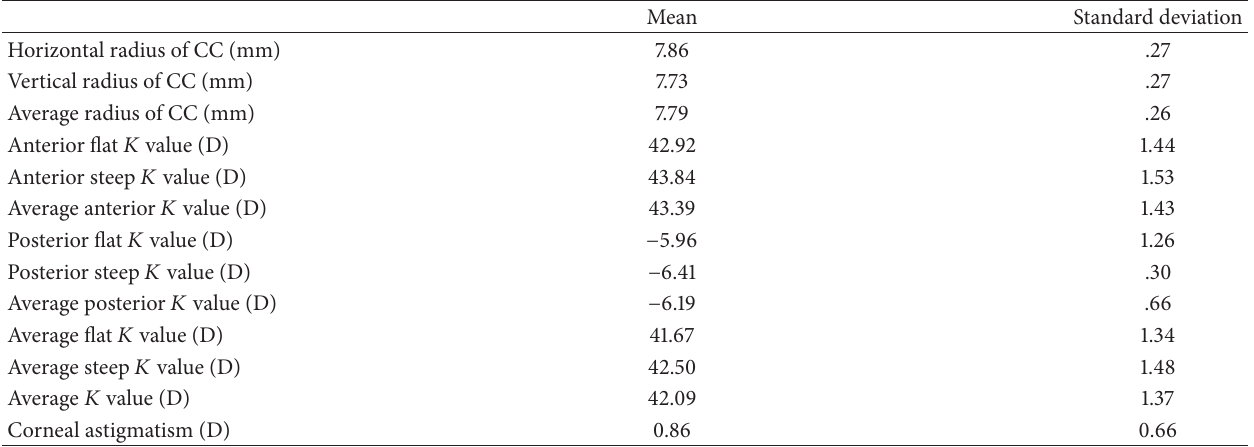
Table 3: The corneal curvature and keratometric values of both anterior and posterior